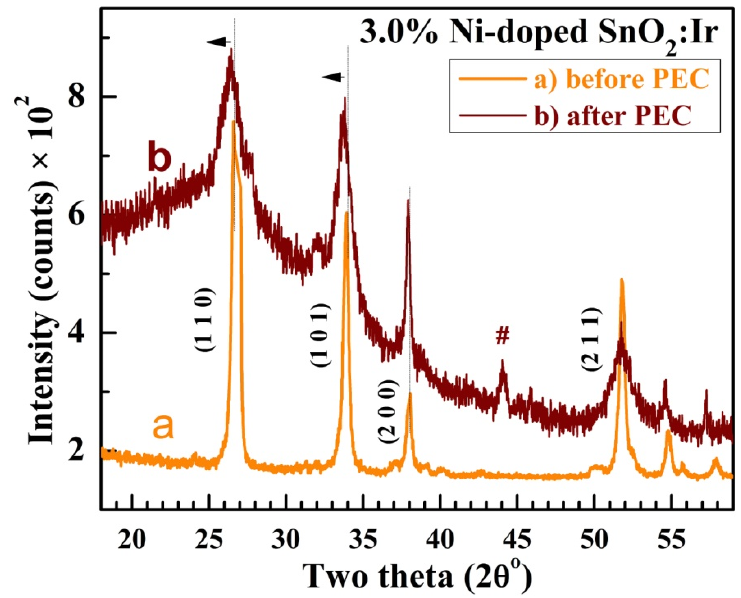
Figure 12. XRD patterns of the 3.0% Ni-doped SnO2:Ir before and after PEC measurements. The arrows ( ) shows the shift of peaks peaks after PEC and (#) denotes to unknown peak.